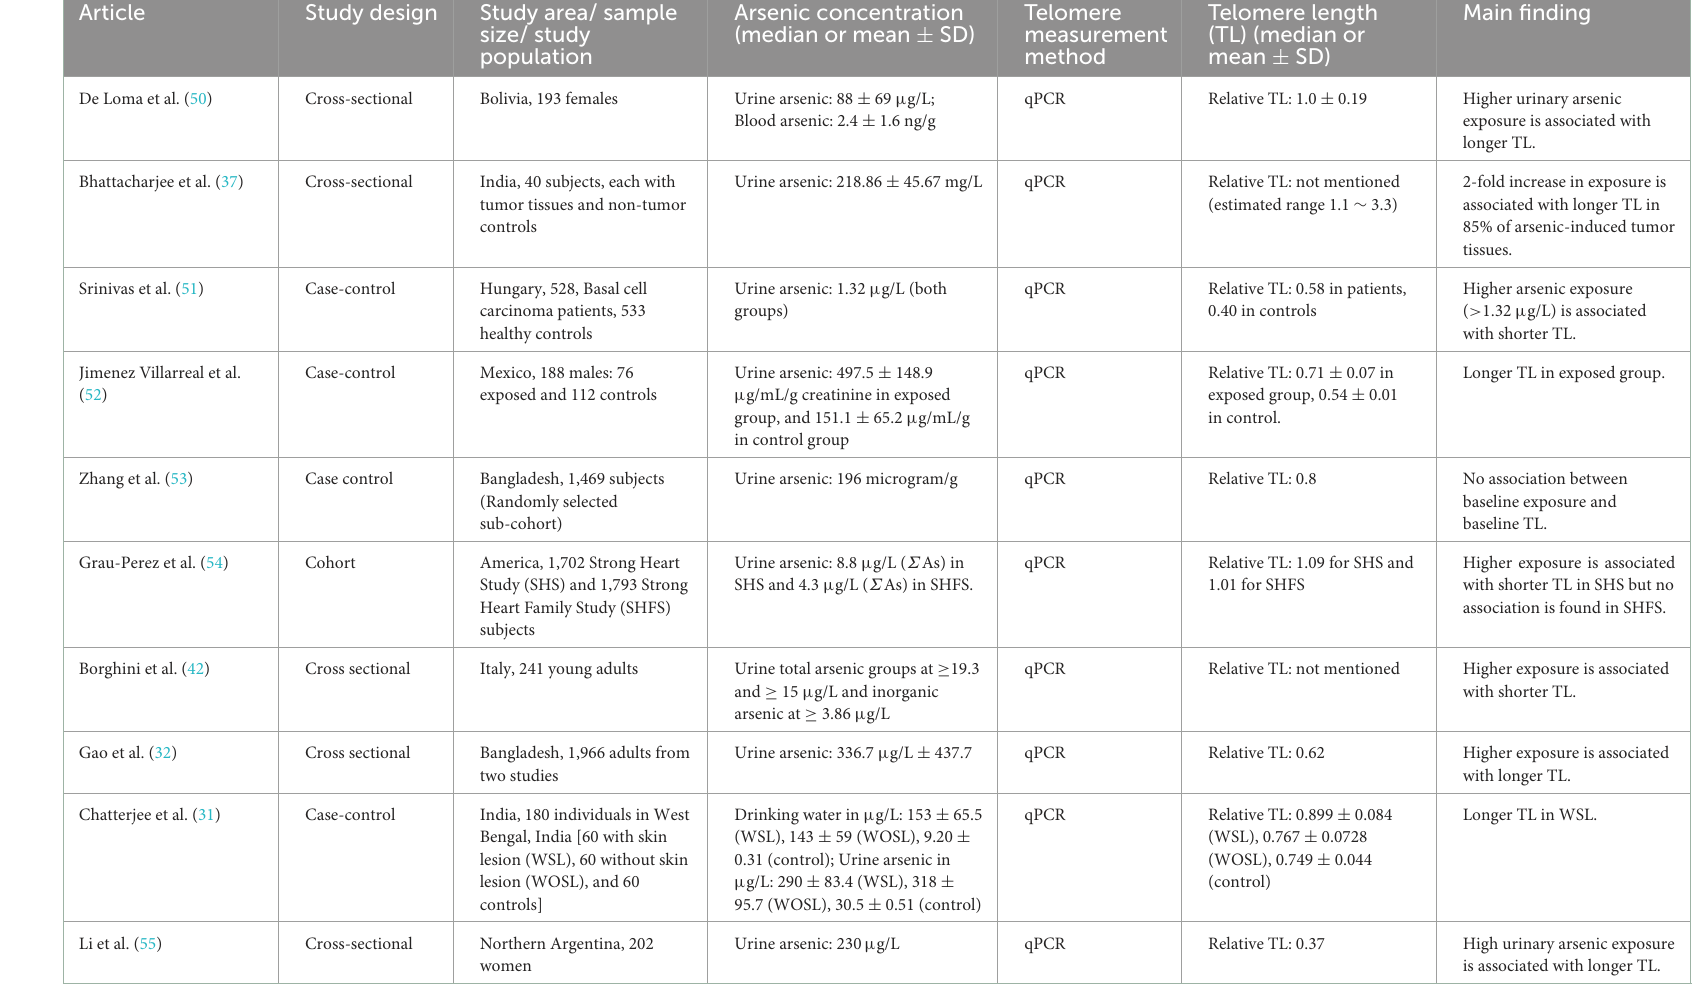
TABLE 1 Summarized studies regarding the associations between arsenic exposure and telomere length in